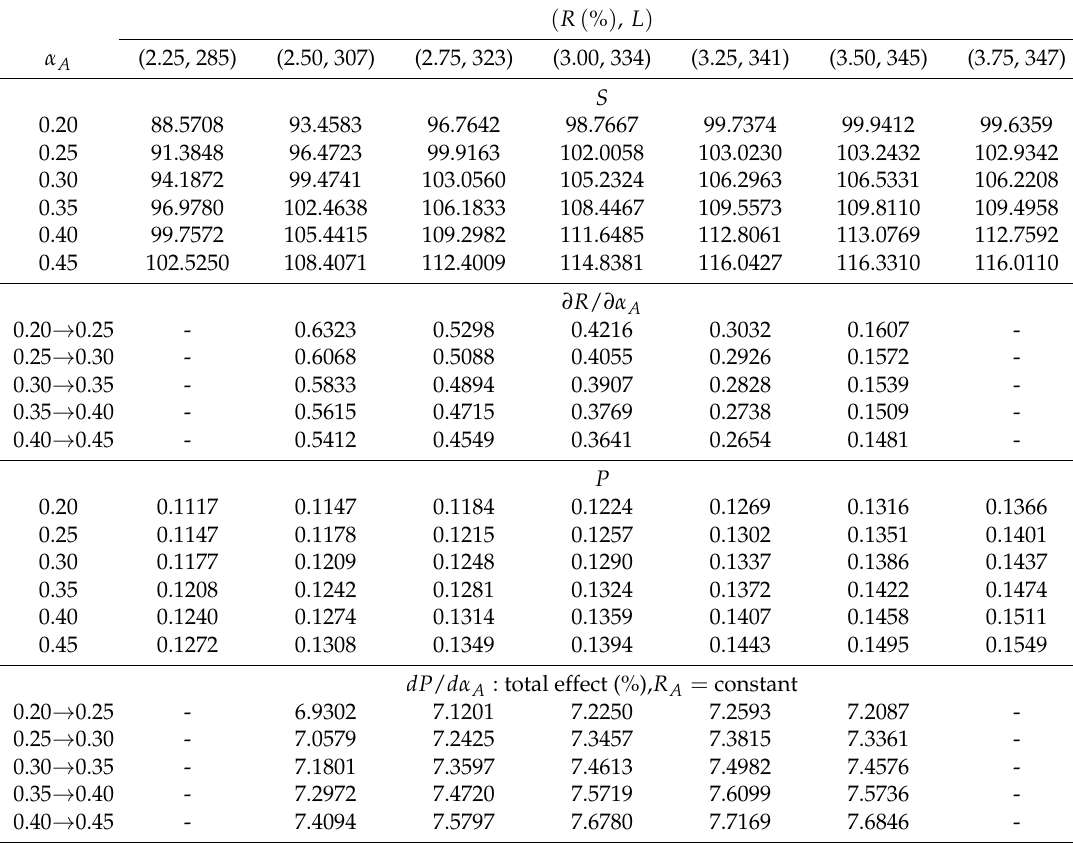
Table 3. Responsiveness of liability-side interest margin (guaranteed interest rate) and default risk to CEO overconfidence degree based on Equations (13) and (15) 1